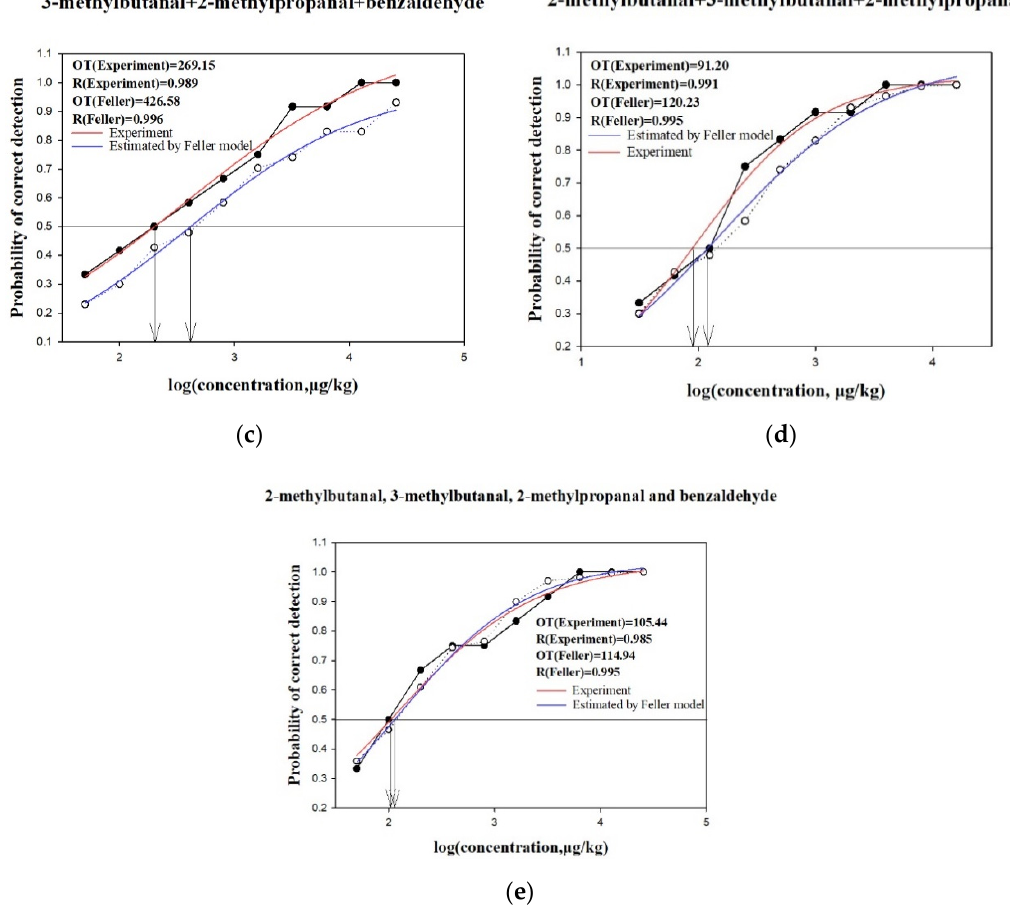
Figure 3. Perceptual interactions among four ternary mixtures and one quaternary mixture as determined using Feller’s additive model. ( a ) 2-Methylbutanal, 3-methylbutanal, and benzaldehyde; ( b ) 2-methylbutanal, 2-methylpropanal, and benzaldehyde; ( c ) 3-methylbutanal, 2-methylpropanal, and benzaldehyde; ( d ) 3-methylbutanal, 2-methylbutanal, and 2-methylpropanal; ( e ) 2-methylbutanal, 3-methylbutanal, 2-methylpropanal, and benzaldehyde. The horizontal line indicates that the correct detection probability is 50%. The two arrows represent the corresponding log (concentration) values under the correct detection probability of 50%. OT, olfactory threshold. R—Feller’s additive model fitting